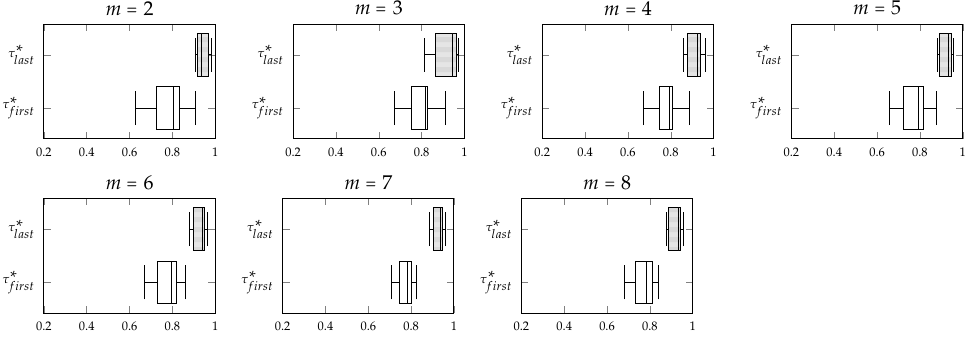
Figure 7. Variation of the concordance indices τ ∗ of experts m (Category corn).